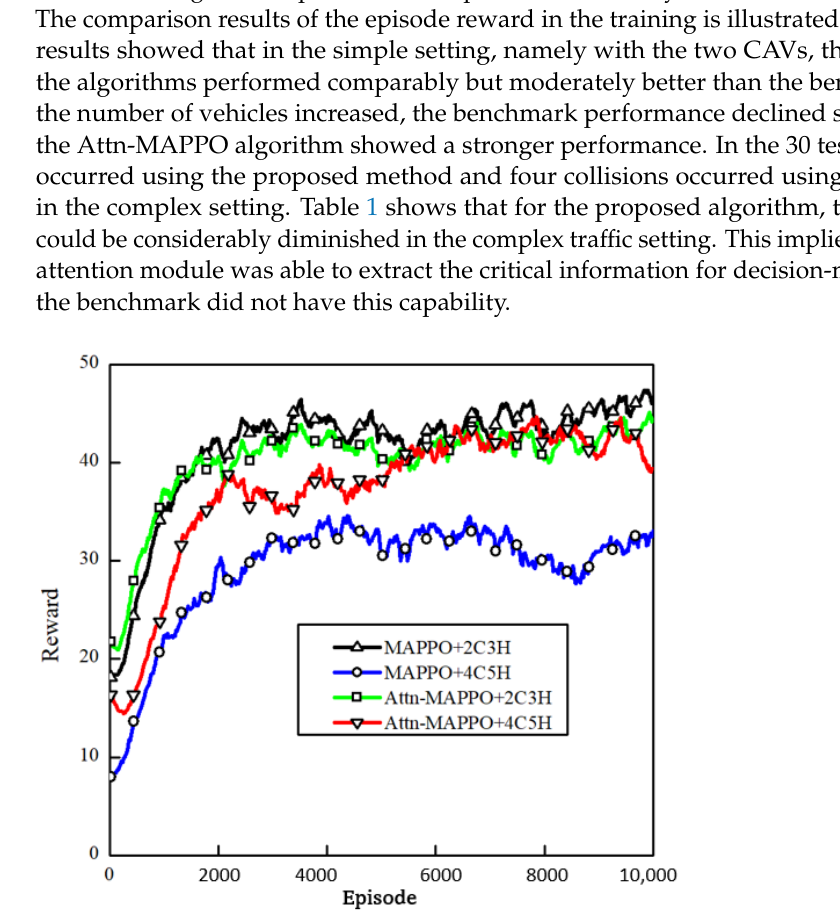
Figure 5. Comparison of the episode reward in the training between the benchmark and the proposed Attn-MAPPO (proposed) algorithm.